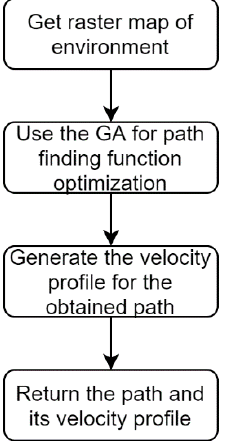
Figure 3. General algorithm flowchart [22].